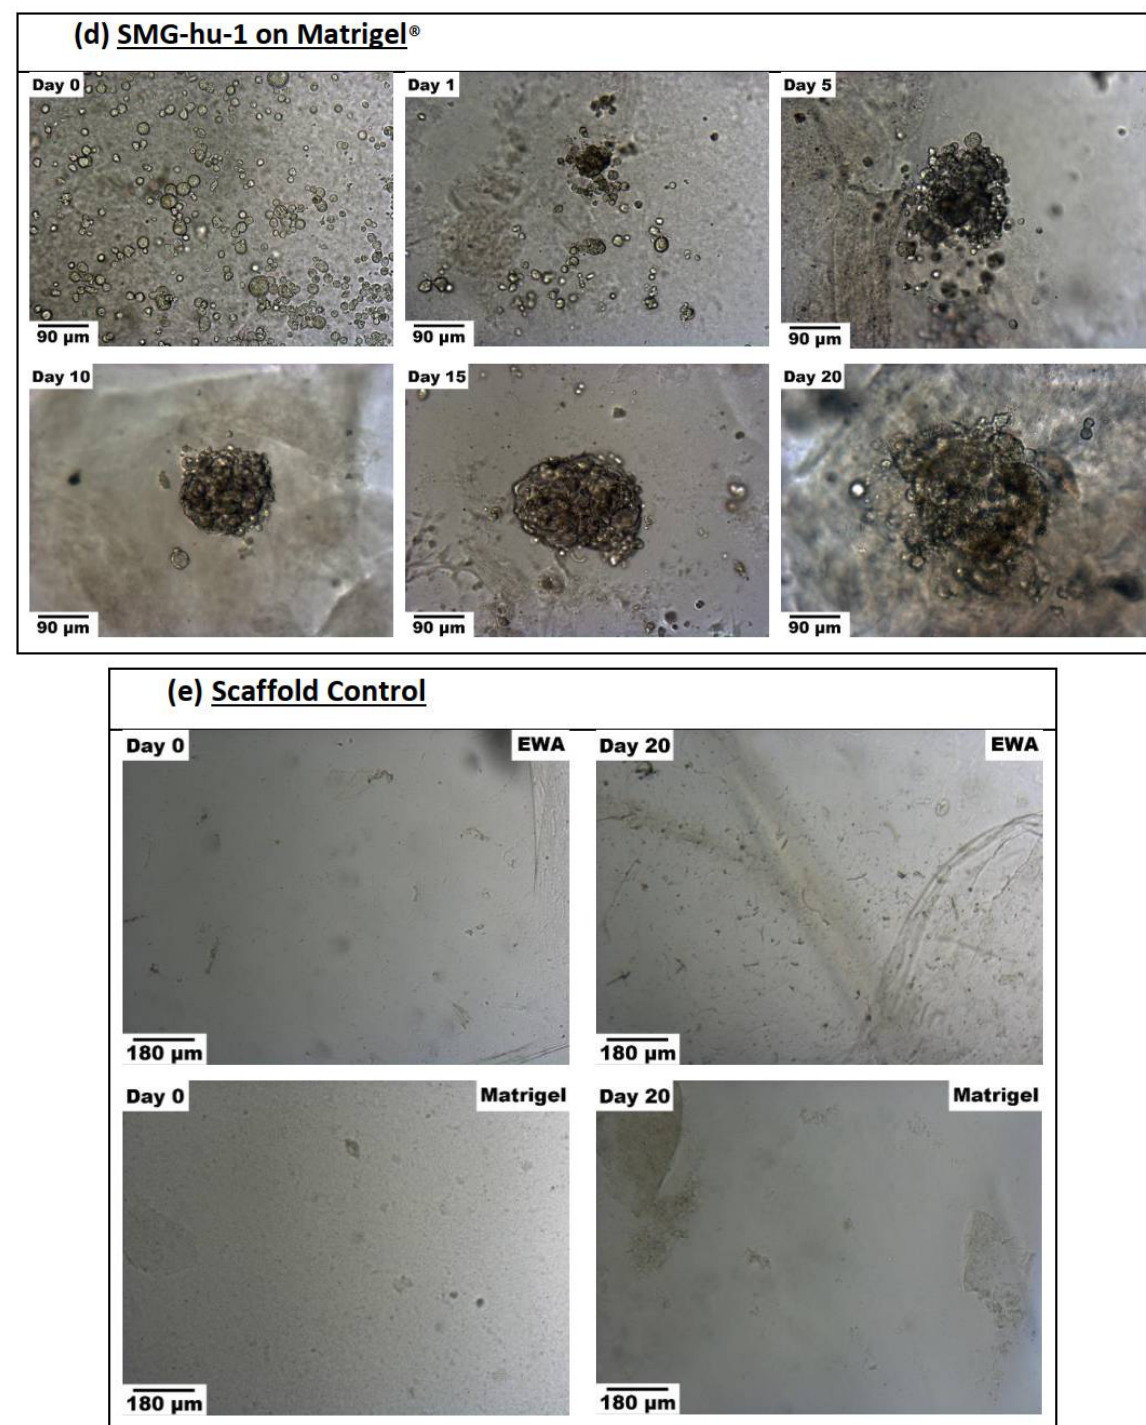
Figure 6. ( a – e ). Comparison of progression in cell growth and spheroid formation of cells grown on EWA and Matrigel ® : ( a ) NS-SV-AC cells grown on EWA. ( b ) NS-SV-AC grown on Matrigel ® ; ( c ) SMG-hu-1 cells grown on EWA; ( d ) SMG-hu-1 cells grown on Matrigel ® ; ( e ) EWA and Matrigel ® grown without any cells. Each group ( a – d ) contains a chronological series of photos taken on day 0, 1, 5, 10, 15, and 20. All images were taken with a bright-light microscope at 100 × magnification and at random. The black scalebar on the bottom left corner of every image in Figure 6a–d represents 90 µ m; the scale bar on the bottom left corner of images in Figure 6e represents 180 µ